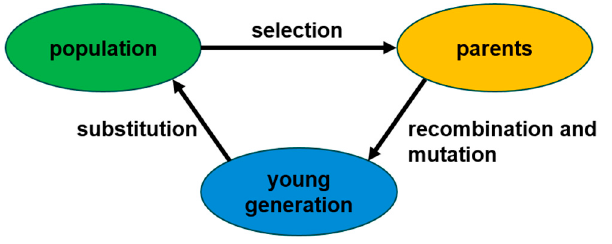
Figure 6. Structure of the Genetic Algorithm: The sequence of selection, recombination, mutation, and substitution is iteratively repeated until a stopping criterion is reached. and substitution is iteratively repeated until a stopping criterion is